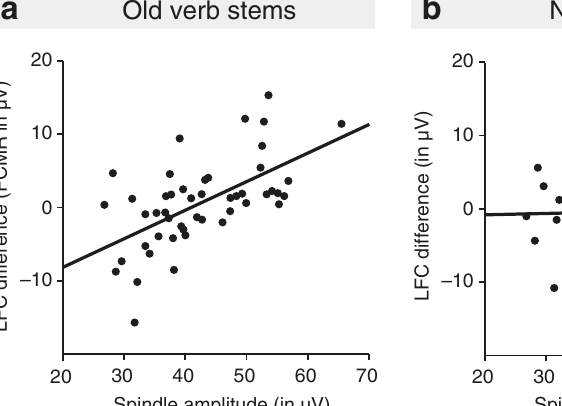
ERP difference between irregular and regular sentences in the LFC region for phrases with new verb stems (Pearson ’ s r =0.045, P =0.763, 95% CI=[ − 0.243, 0.325], two-sided). The correlation coef fi cient for new verb stems signi fi cantly differed from that of old verb stems (Meng, Rosenthal, & Rubin ’ s 37,38 z = − 2.844, P =0.004, two-sided). For the corresponding relations between spindle